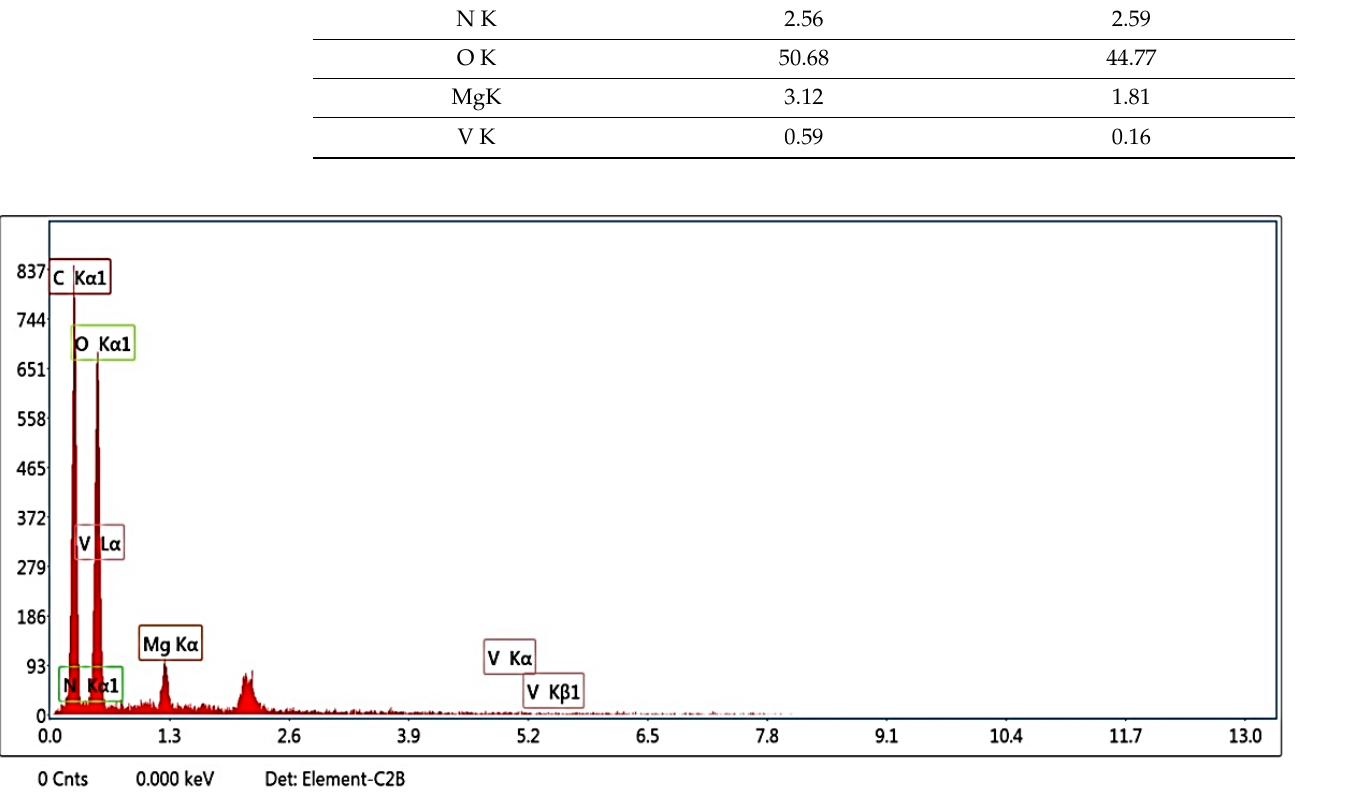
Figure 3. EDAX of Mg 3 (VO 4 ) 2 /MgO/GO@CA film.